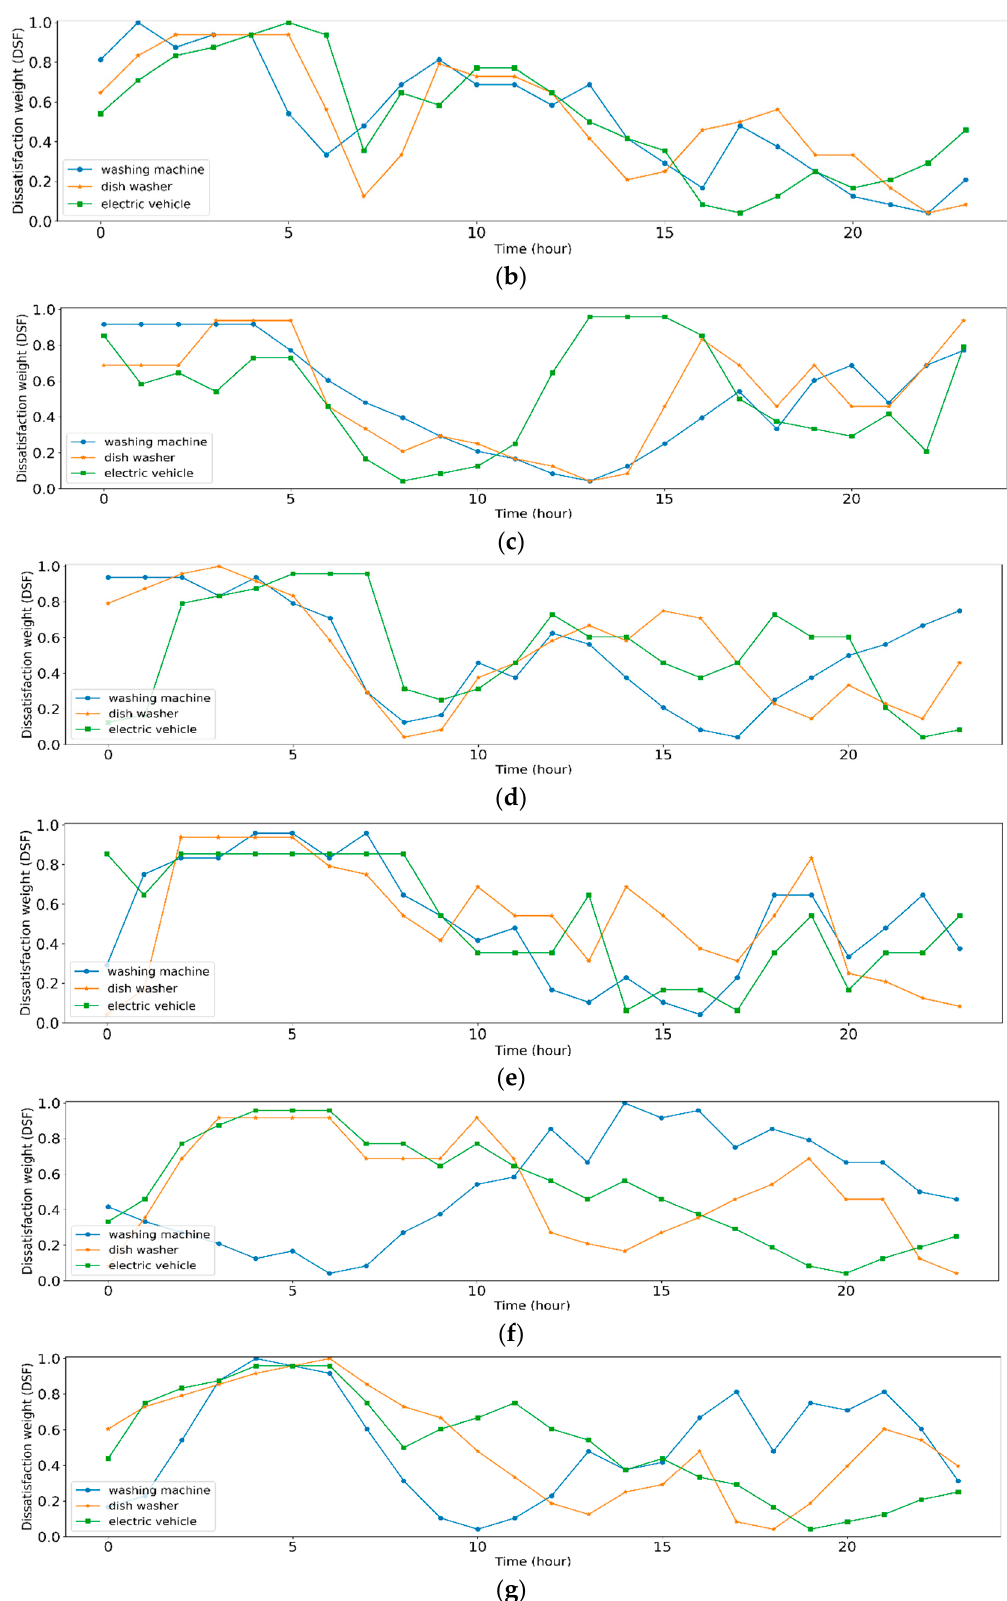
Figure 4. Seven households’ dissatisfaction weights ( a )–( g ) with respect to each time slot. Through the process described in Equations (20)–(22), the dissatisfaction weights of each time slot were derived. When the dissatisfaction weight is small at time t , it means that the residential customer has a greater probability of using the appliance at time t compared to the other time. In